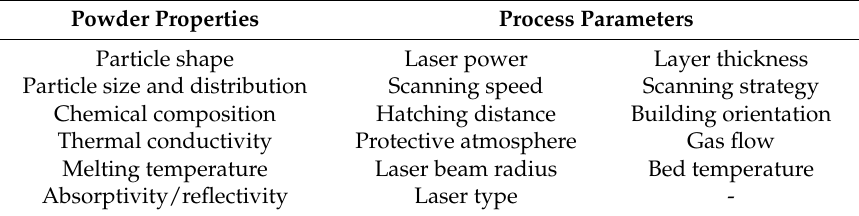
Table 1. Selective Laser Melting (SLM) variables.